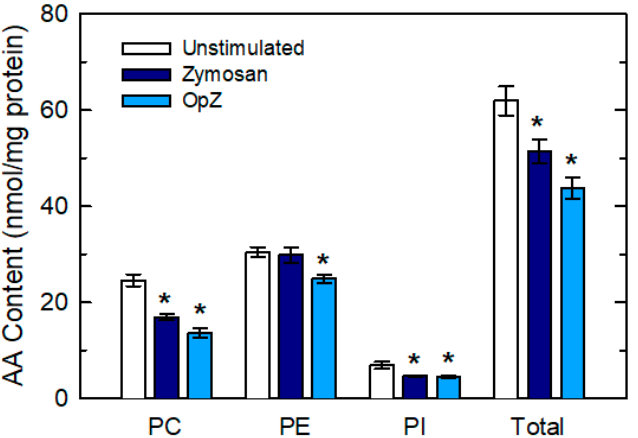
Figure 6. Effect of cellular stimulation on the levels of AA in different phospholipid classes. The cells were untreated (open bars) or treated with 1 mg/mL zymosan (dark blue bars) or 1 mg/mL OpZ (light blue bars) for 1 h. The AA content of the various phospholipid classes was determined by gas chromatography/mass spectrometry (GC/MS). Data are expressed as means ± S.E.M. ( n = 6). * p < 0.05, significantly different from unstimulated cells.